Question: Express in one sentence what the figure is showing.
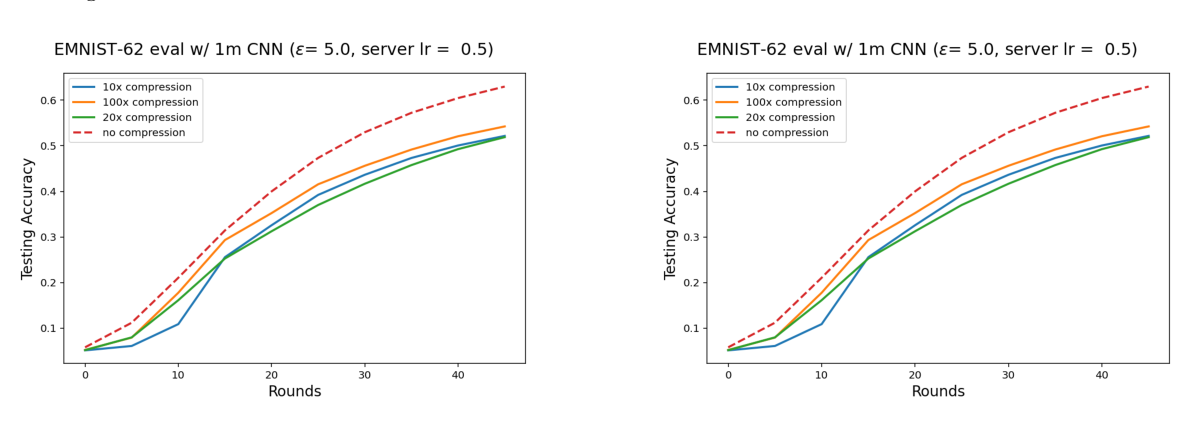
Answer: Accuracy of MF and SGMF on EMNIST, with δ = 10−5, clipped norm ∆2 = 0.03, and server learning rate 0.5.